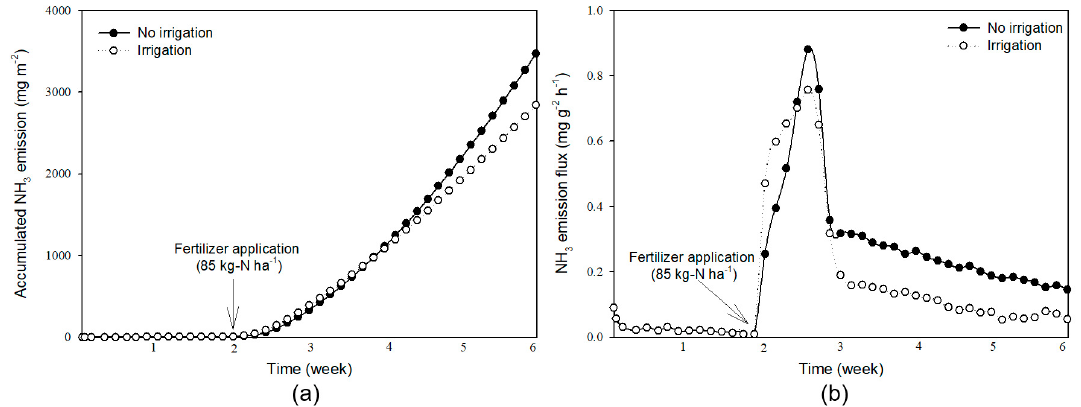
Figure 5. Changes in accumulated NH 3 emission ( a ) and NH 3 emission flux ( b ) when chemical fertilizer was applied to soil during a six-week period.